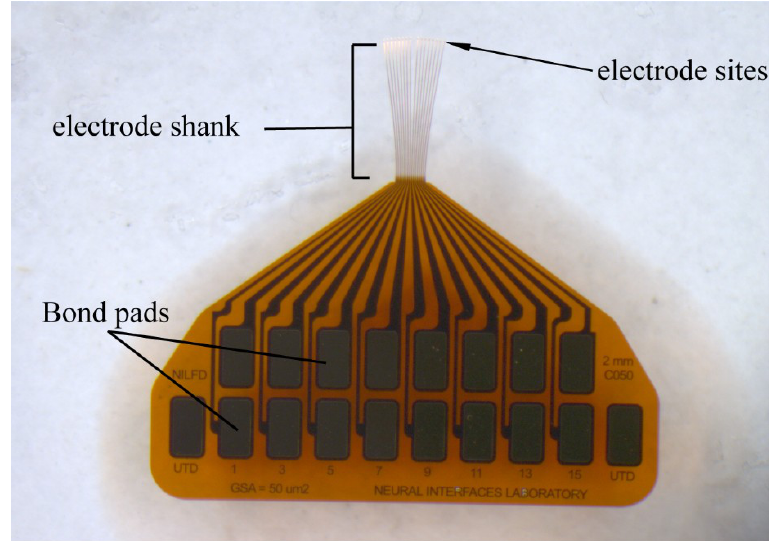
Figure 1. Example of the 16-channel a-SiC microelectrode array (MEA) showing bond pads at the proximal end, 2 mm long electrode shanks, and electrode sites located at the distal tips.